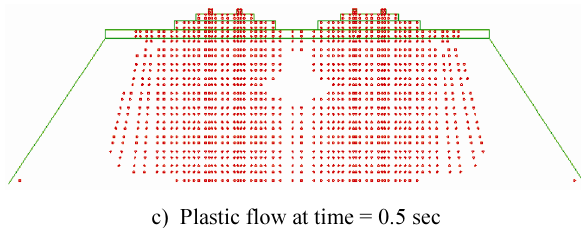
Fig. 10. Spread of plastic flow at different duration